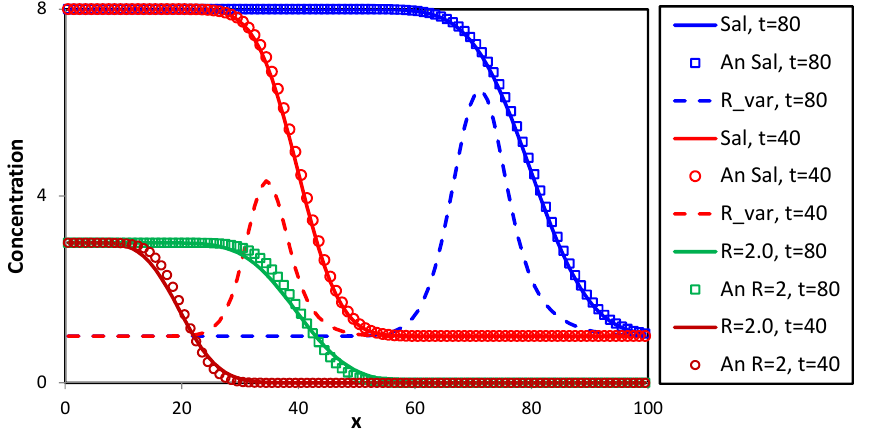
Figure 7. Distribution (at t = 40, red, and 80 d, blue) of salinity (Sal) that enters (Sal = 8) into a medium with low salinity. A second solute (dashed) enters with the same concentration as resident water, but salinity changes from 2 to 1 its retardation, producing a peak at the salinity front. Note that numerical solution of Sal (lines) with a Lagrangian method is visually identical to the analytical solution (symbols). The same numerical method produces some numerical dispersion for a third solute with constant retardation.